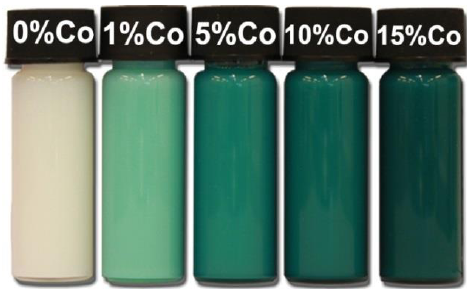
Figure 44. Visual comparison of changes in colours of suspensions of Zn 1− x Co x O NPs depending on the dopant content. Reprinted with permission from [799], Copyright © 2015 Glass Ceram (Warsaw, Poland).